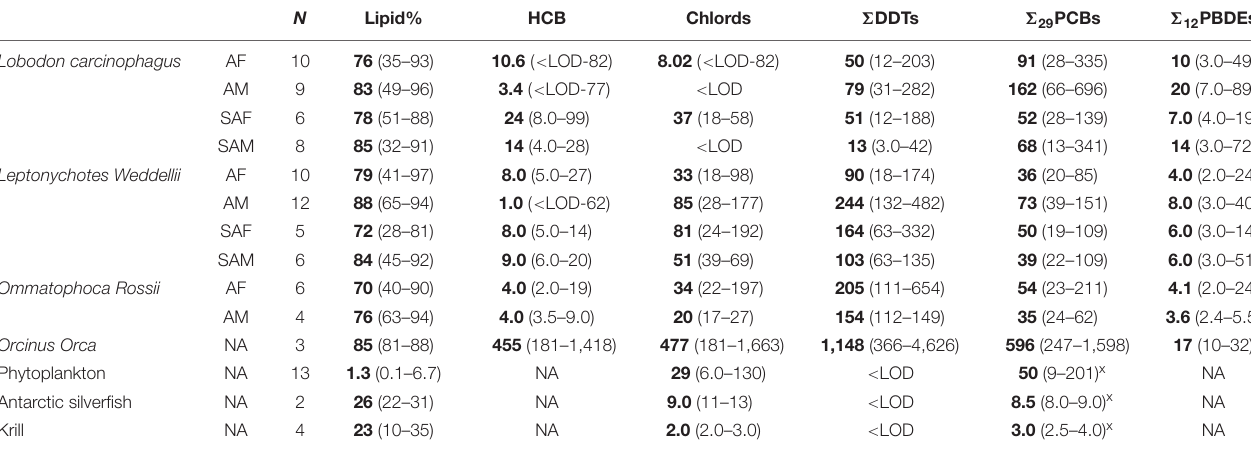
TABLE 1 | Geometric means (in bold) and range (in brackets) of OCPs (HCB, Chlords and DDT), PCBs and PBDEs ng/g lipid) in the blubber samples of the three seal species and killer whales, Values from phytoplankton, the Antarctic silverfish and krill are from Brault (2012). N Lipid% HCB